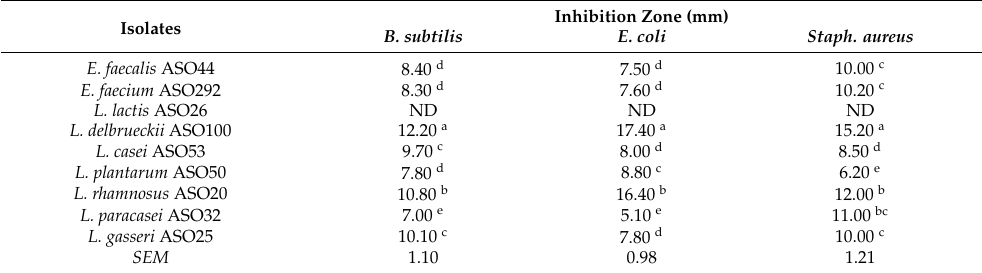
Table 6. Effect of antimicrobial activity of some lactic acid bacteria on some pathogenic and spoilage